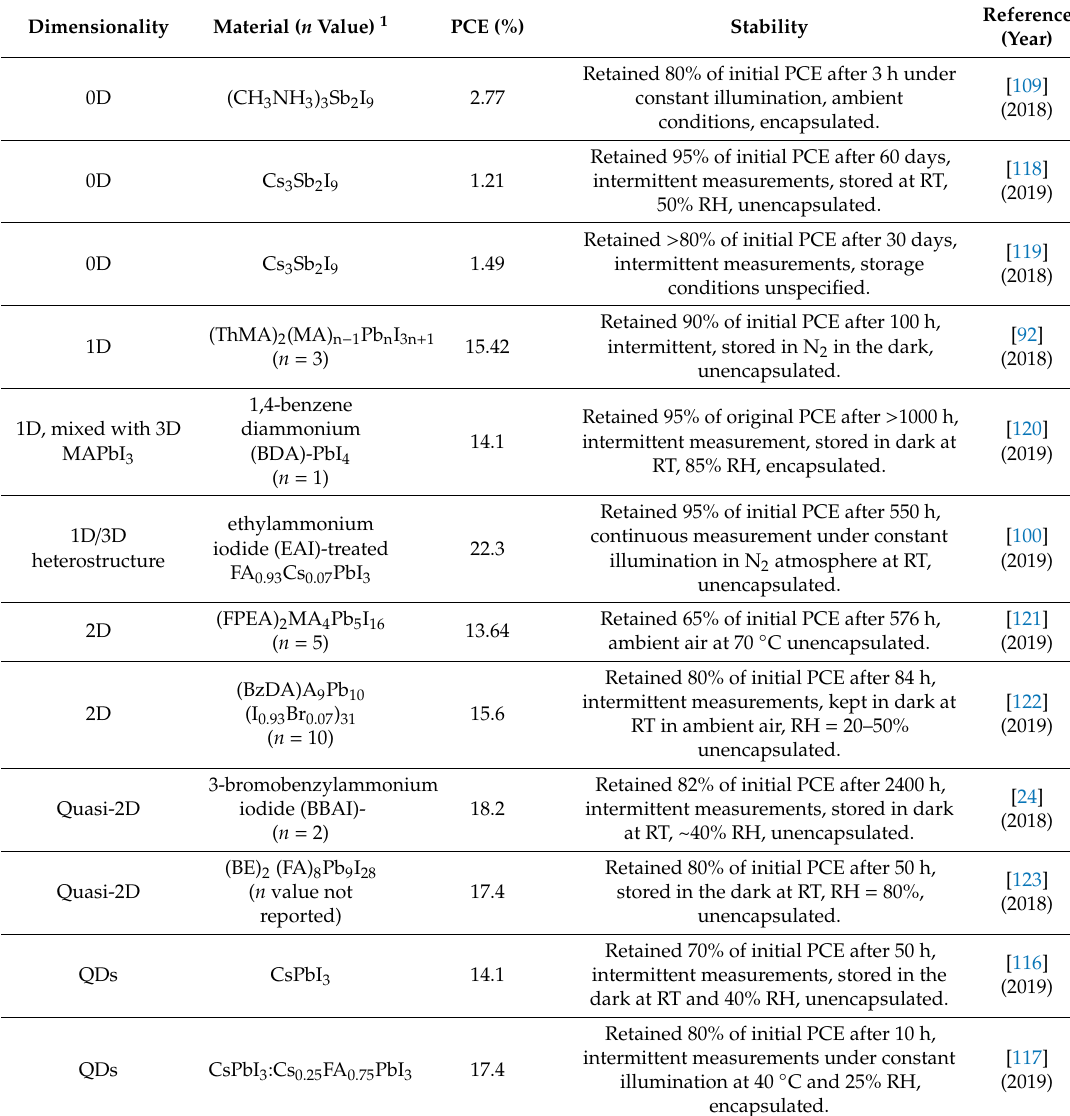
Table 1. A selection of notable reports on low-dimensional perovskite solar cells. QDs, PCE, RT, and RH stand for quantum dots, power conversion e ffi ciency, room temperature, relative humidity,